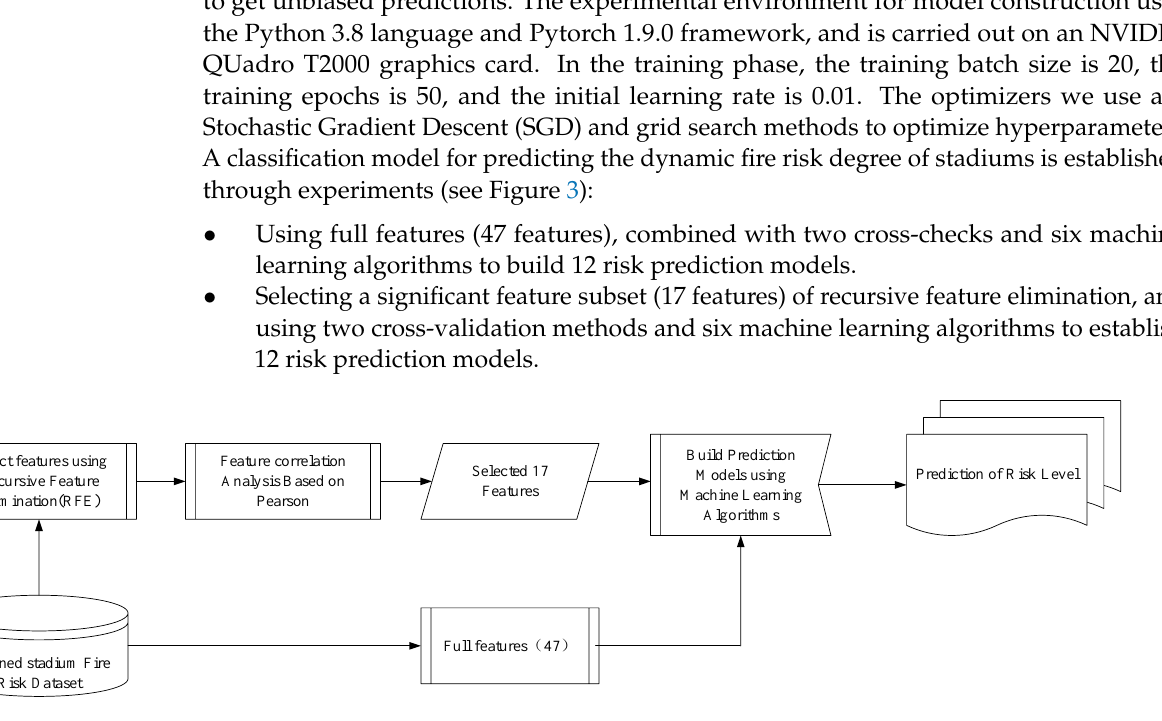
Figure 3. Risk prediction model developed using significant features and machine learning algo- rithms.